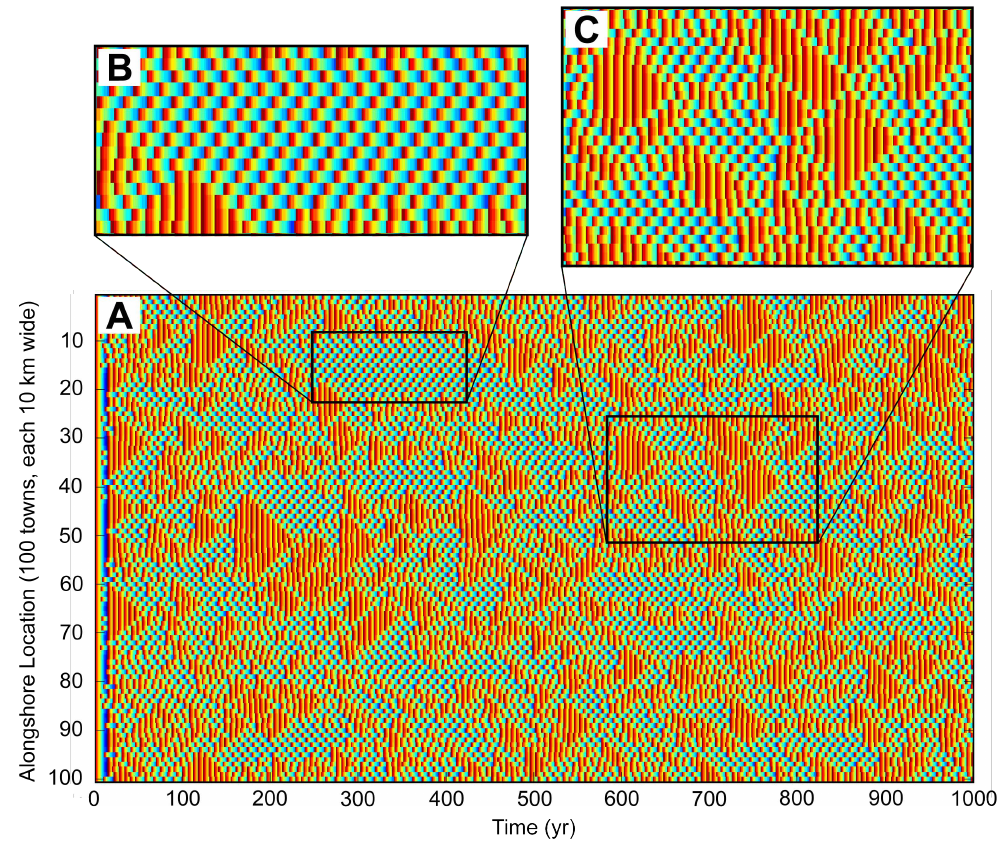
Fig. 4. (a) Beach width through time for 100 towns over 1000yr for γ r = 3.5myr − 1 . Insets highlight two quasi-stable states: (b) checker- board patterning; and (c) dissipative